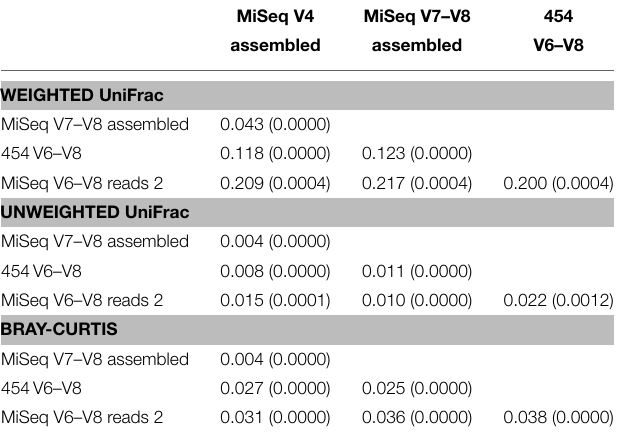
TABLE 3 | M 2 and Monte Carlo P -values * (10,000 permutations) Procrustes rotation comparison of weighted UniFrac, unweighted UniFrac and Bray-Curtis